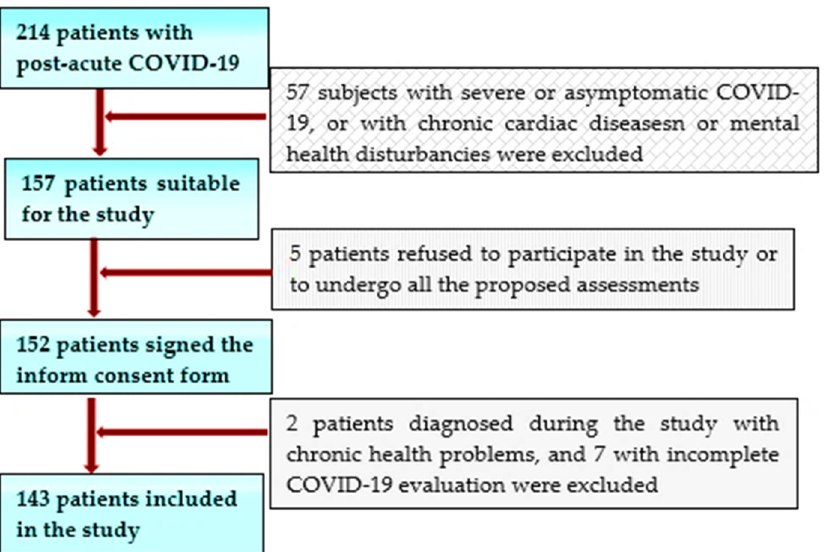
Figure 1. Timeline for the selection of the study population.